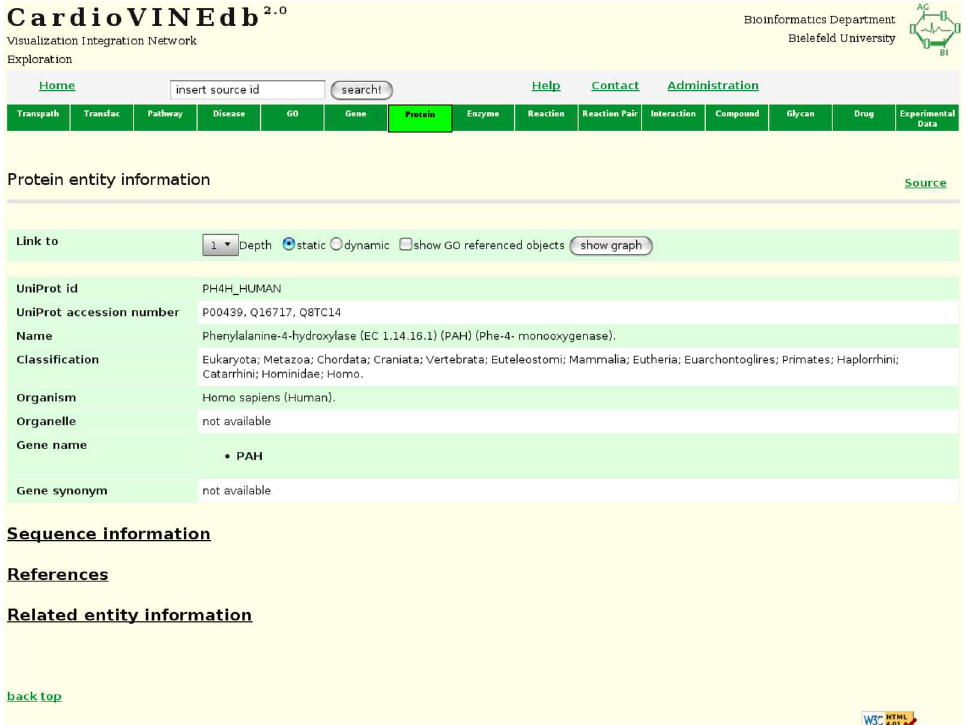
Figure 3: Detailed result page for the protein PH4H HUMAN in CardioVINEdb merging the data from different sources for that entry.